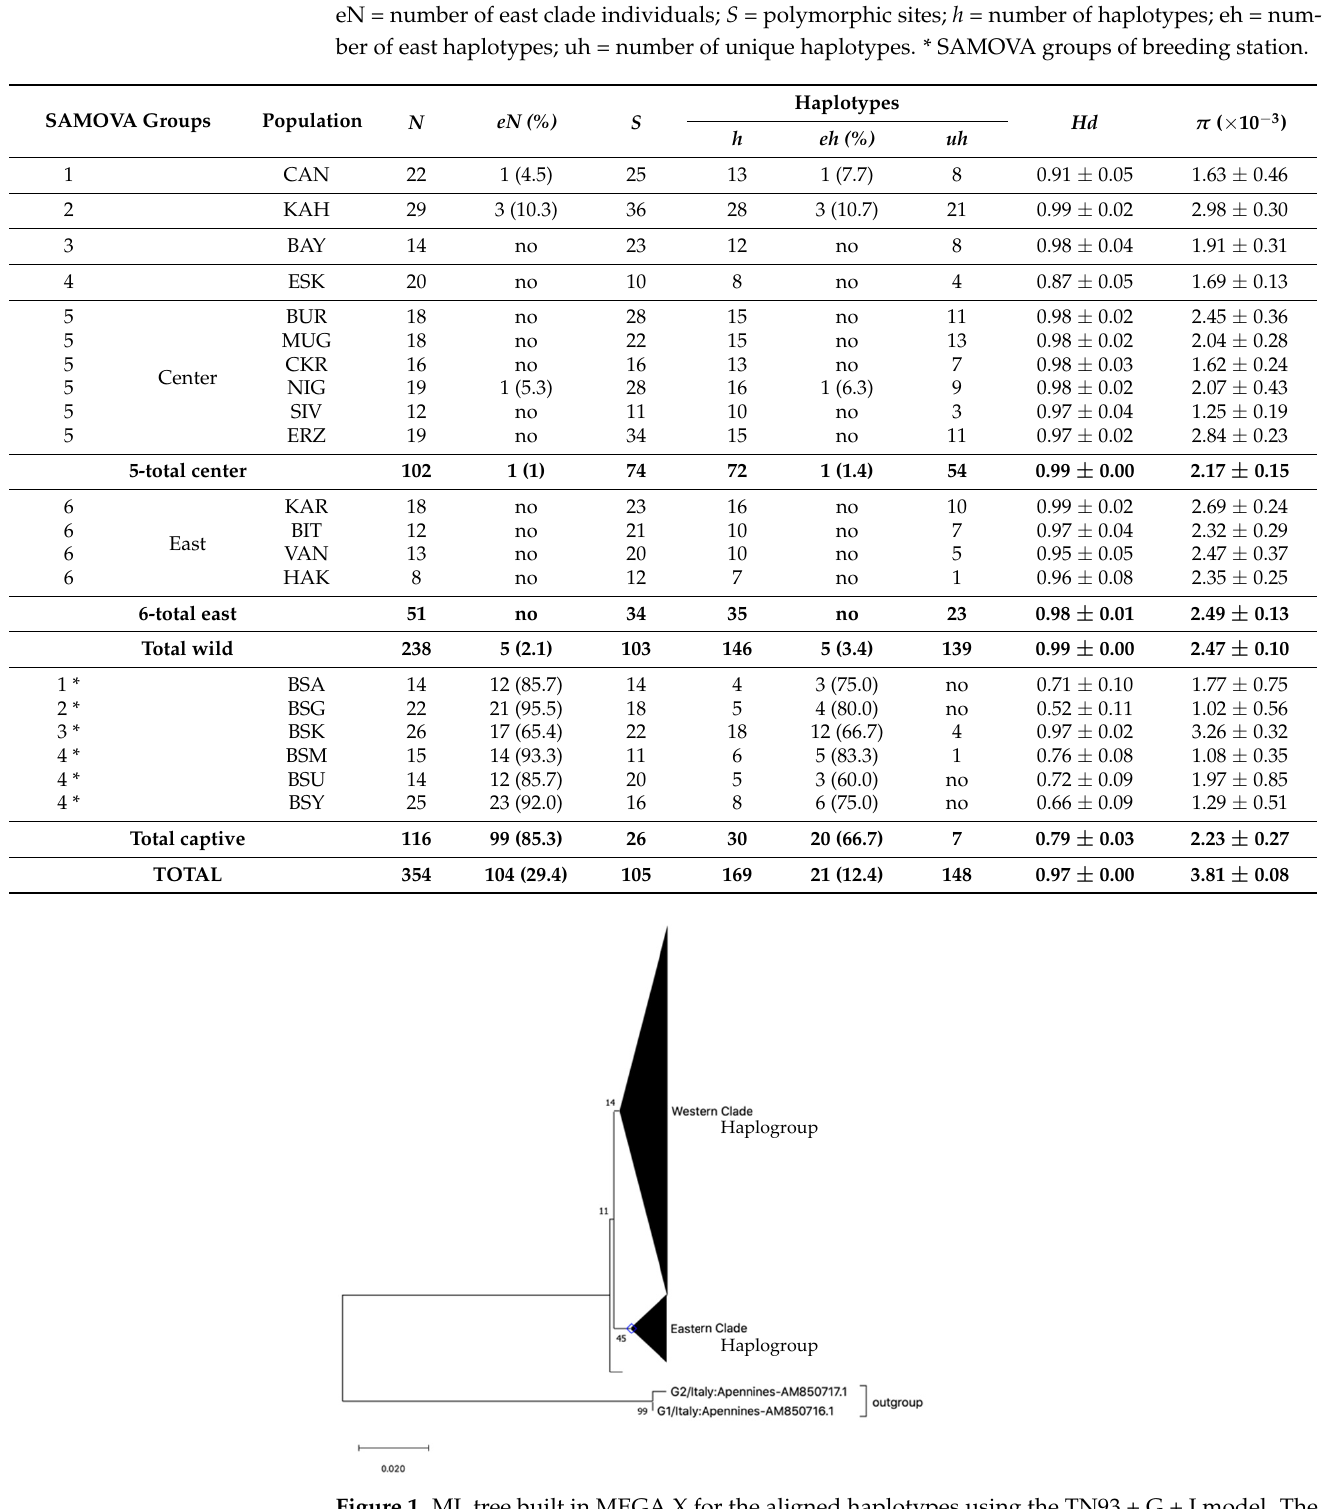
Figure 1. ML tree built in MEGA X for the aligned haplotypes using the TN93 + G + I model. The posterior probability of trees in which the associated taxa clustered together is shown next to the branches. Haplotype details are given as Supplementary Documents S1 and S2. Admixed individuals were excluded from this analysis.